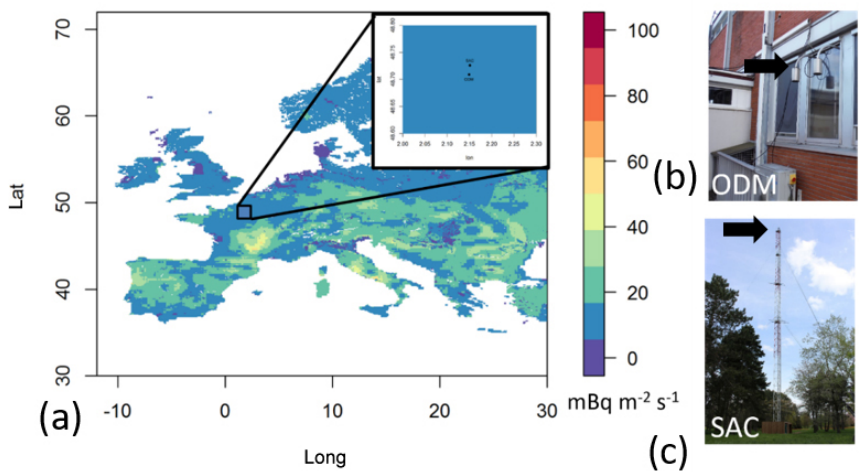
Figure 1. The INGOSv2.0 222 Rn flux map (Karstens et al., 2015) is shown for a typical winter month (December), with locations of the ODM and SAC sites shown in the inset in (a) . The radon sampling inlets are indicated for both ODM (b) and SAC (c) by the black arrows.